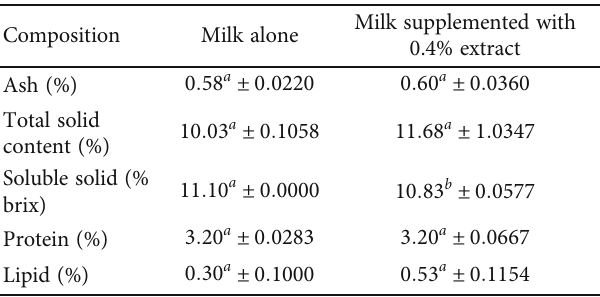
Data are shown as means ± SD ( n = 3 ). Di ff erent superscripts in rows (a and b) mean signi fi cant di ff erence between groups ( p < 0 : 05 ). Statistical comparisons were made between samples using the independent sample t